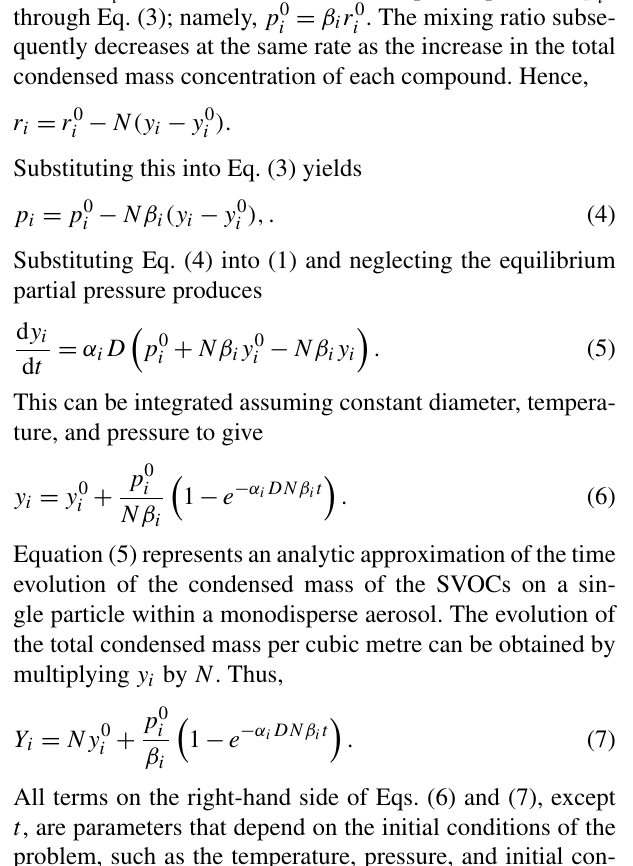
Figure 2. The ratio of the equilibrium partial pressure, p eq partial pressure, p i , of each of the organic compounds on each of the modes as a function of relative humidity. Each colour shows a different volatility bin. On the first mode (a) the compounds with the lowest five C ∗ values look indistinguishable from each other and are all shown by the purple line. Similarly, the six compounds with the lowest C ∗ values in the second and third plots (b, c) are shown by the blue